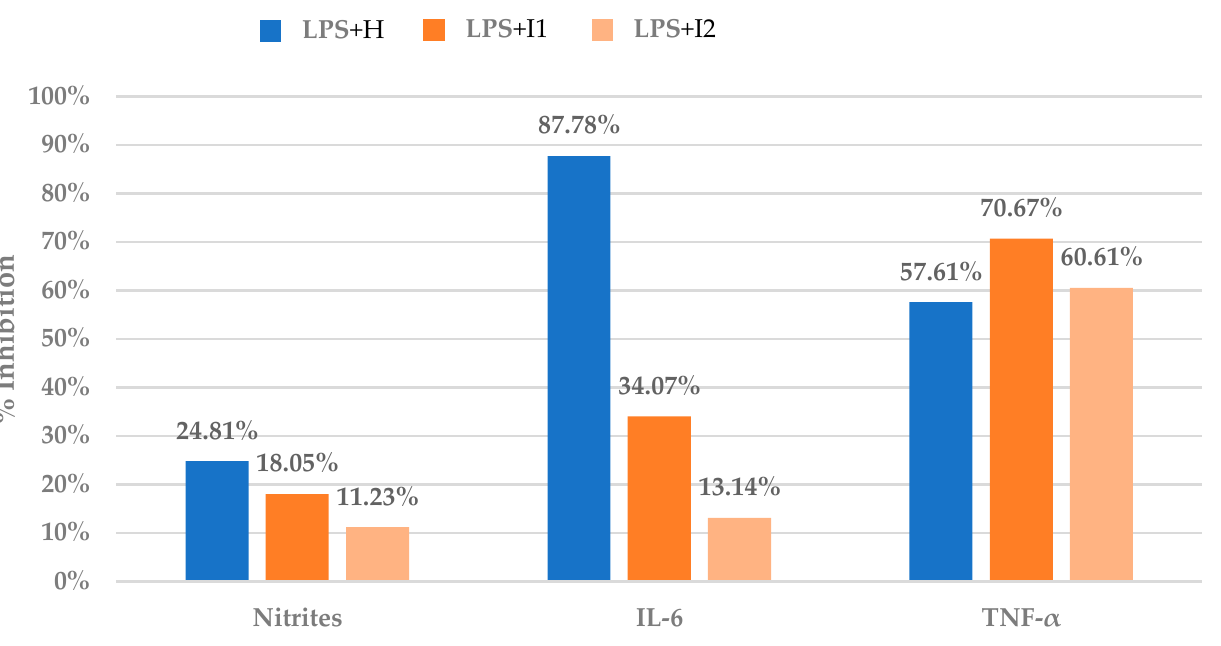
Figure 1. Results of anti-inflammatory assay on a macrophage cell line (RAW 264.7) of two treatment concentrations (LPS + I1 and LPS + I2; see Section 2.3). Results are calculated as percentage of inhibition of mediators’ release against sample LPS. The positive control is LPS + H.